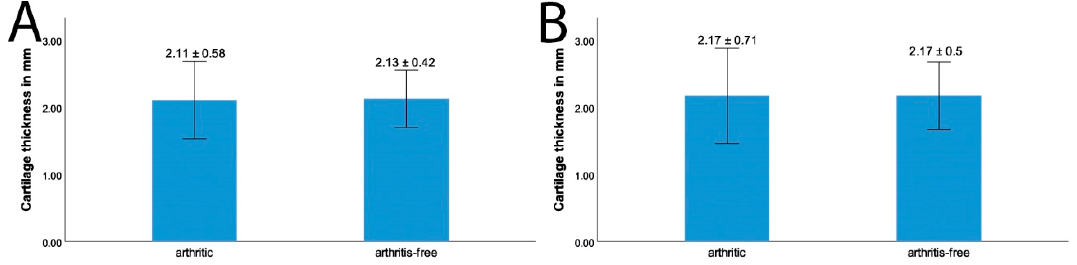
Figure 5. ( A ) Differences in entire meniscus-covered cartilage thickness in mm: arthritic: 2.11 ± 0.58 mm; arthritis-free: 2.13 ± 0.42 mm (error bar: 1 SD). ( B ) Differences in meniscus-covered cartilage thickness in the mid part in mm: arthritic: 2.17 ± 0.71 mm; arthritis-free: 2.17 ± 0.5 mm (error bar: 1 SD).